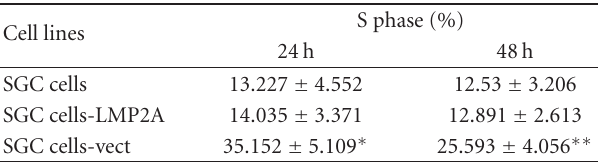
Table 2: Influence of LMP2A expression on cell cycle (FCM analysis) (means ±